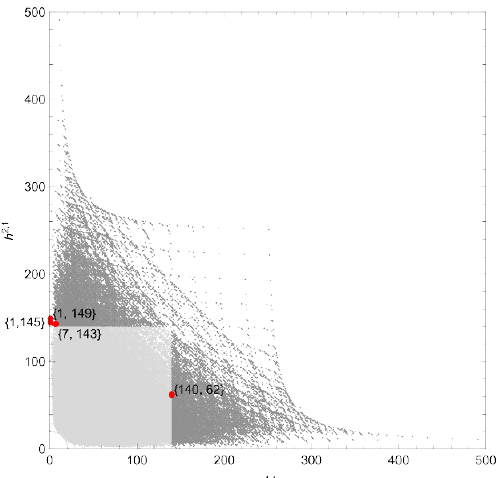
Figure 2 . The four Hodge pairs in the region h 1 ; 1 (cid:21) 240 or h 2 ; 1 (cid:21) 240 associated with polytopes without re(cid:13)exive 2D subpolytopes associated with genus one (including elliptic)